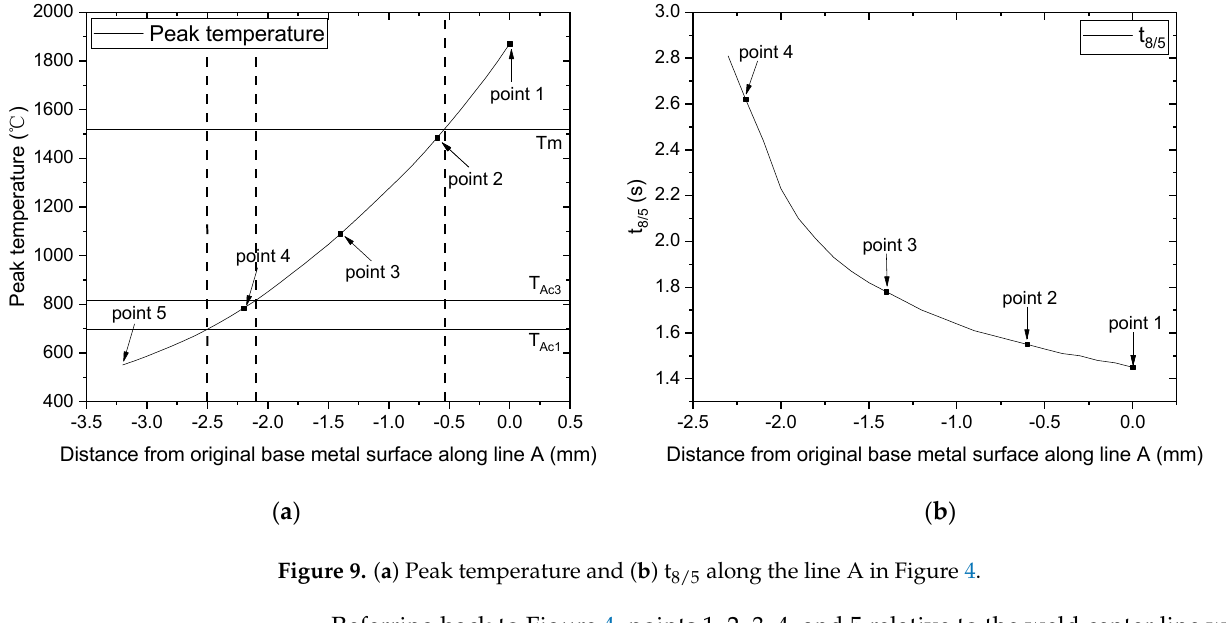
Figure 8. Thermal cycles at di ff erent locations.